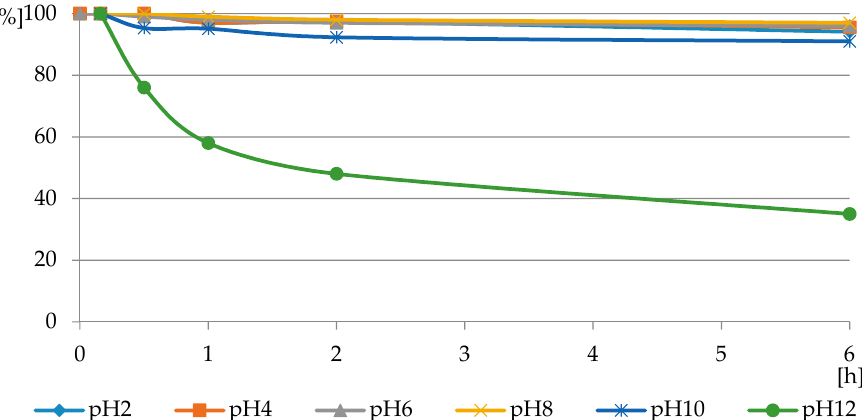
Figure 9. The profile of PMG consumption in reactions with H 2 O 2 in PMG-H 2 O 2 -(UV) systems (with UV irradiation) carried out at a pH range of 2 ≤ pH ≤ 12 and a temperature of 25 °C (residual PMG (%) vs. exposure time (h)).